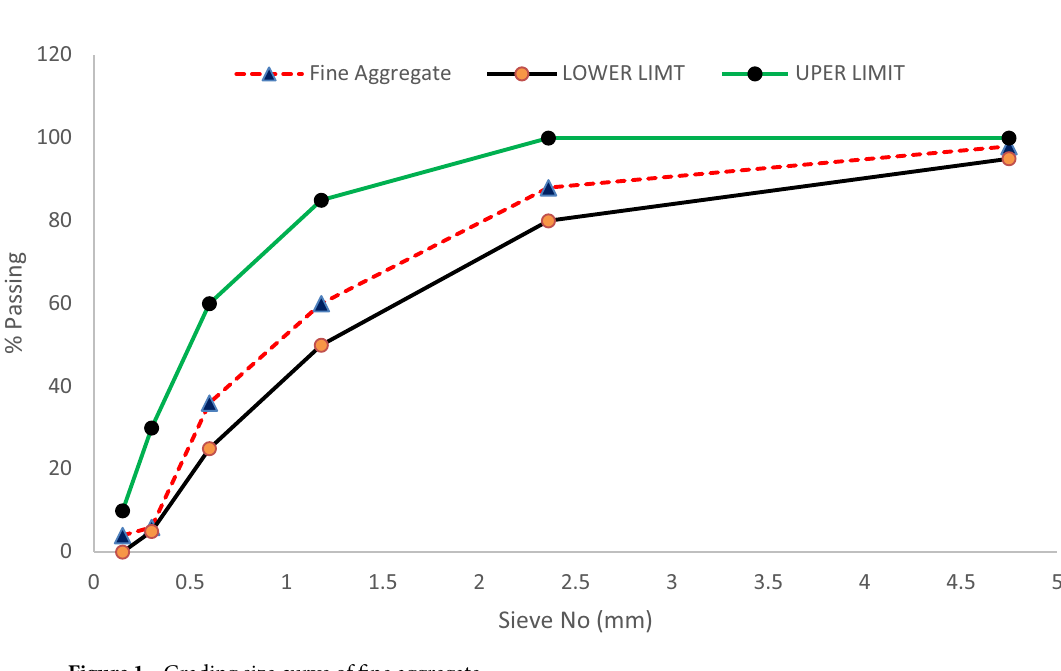
Figure 1. Grading size curve of fine